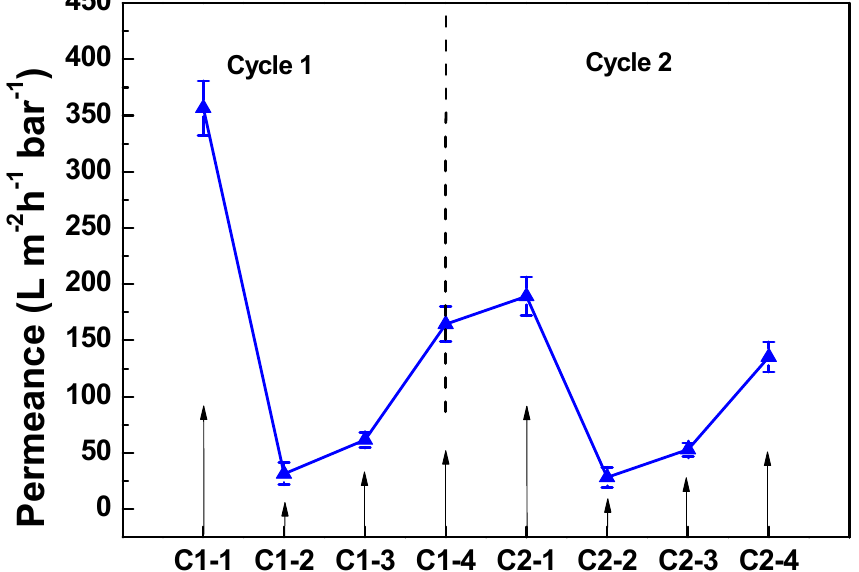
Figure 8. Permeance of PANI/EG composite membranes (virgin, BSA fouled, after fouled and cleaned) under the applied potential of 30 V at two cycles (C1-1 = virgin (Cycle 1), C1-2 = BSA fouled (Cycle 1), C1-3 = after fouled (Cycle 1) and C1-4 = cleaned (Cycle 1); C2-1 = virgin (Cycle 2), C2-2 = BSA fouled (Cycle 2), C2-3 = after fouled (Cycle 2) and C2-4 = cleaned (Cycle 2)). Experimental conditions: applied potential 30 V, operating pressure 2 bar, [BSA] = 1.0 g L –1 , room temperature.